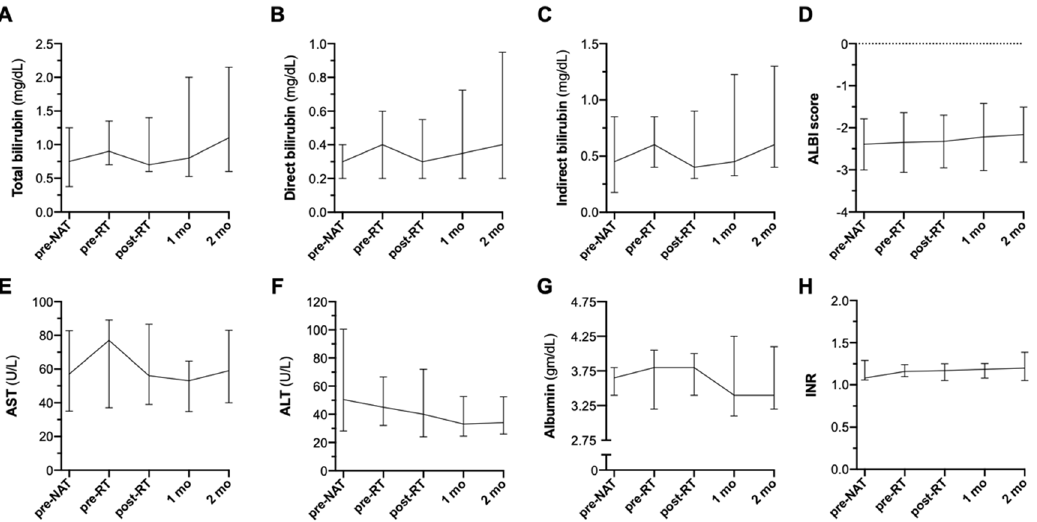
Figure 4. RT with atezolizumab plus bevacizumab does not potentiate acute liver decompensation. Stable transaminase levels were seen 2 months post-treatment as seen in the levels of total ( A ), direct ( B ), and indirect ( C ) bilirubin, ALBI scores ( D ) , as well as AST ( E ), ALT ( F ), albumin ( G ), and INR ( H ) depicted with medians and interquartile ranges (IQR). Comparisons across all time points were statistically insignificant as measured by Wilcoxon signed-rank tests for continuous variables.